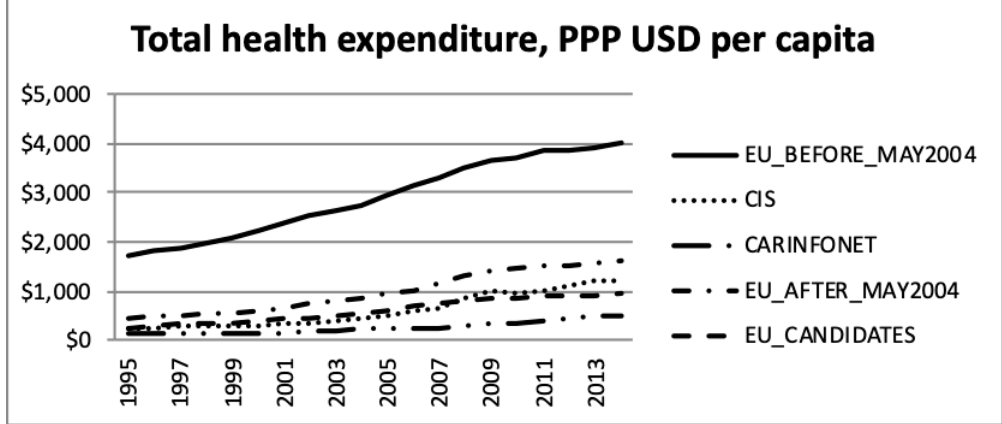
Figure 5. Total health expenditure, purchasing power parity (USD) per capita, the World Health Organisation estimates. Note: